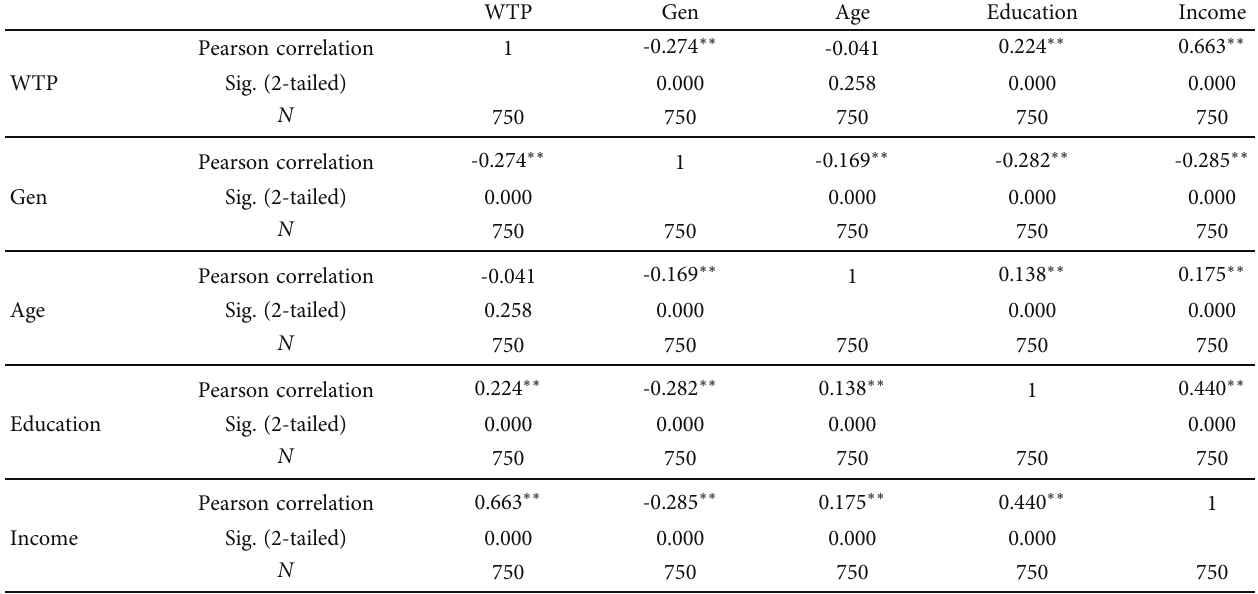
Figure 2: WTP against the pro fi le of the respondents that are among the explanatory variables (source: authors). Table 6: Correlations (source: